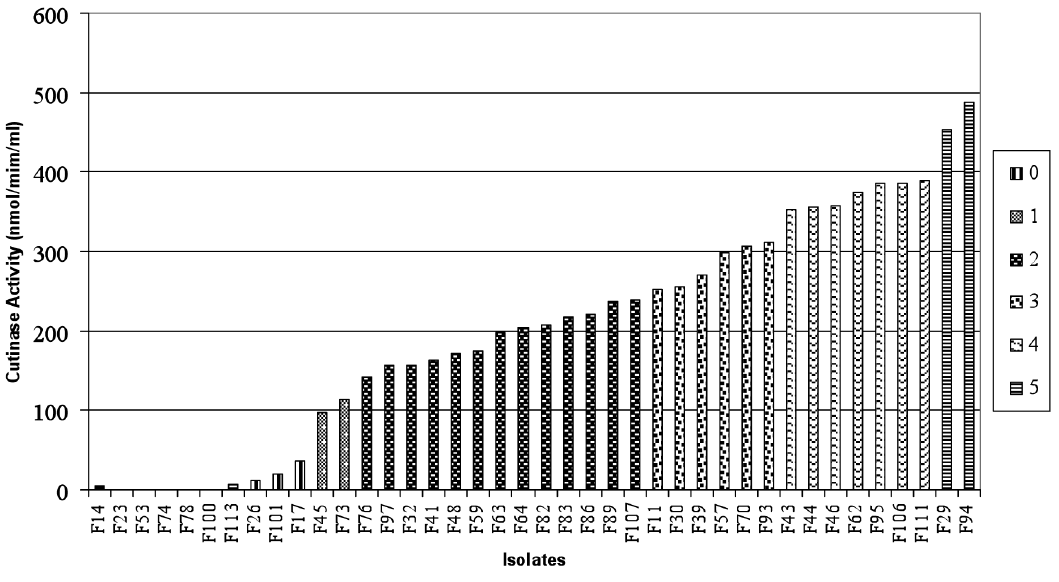
Figure 2. Cutinase activity of Fusarium solani isolates in relation to their pathogenicity/virulence. 0, no rot; 1, 50 – 100 mm 2 of rotted area; 2, 101–150; 3, 151–200; 4, 201–250 and 5>250.